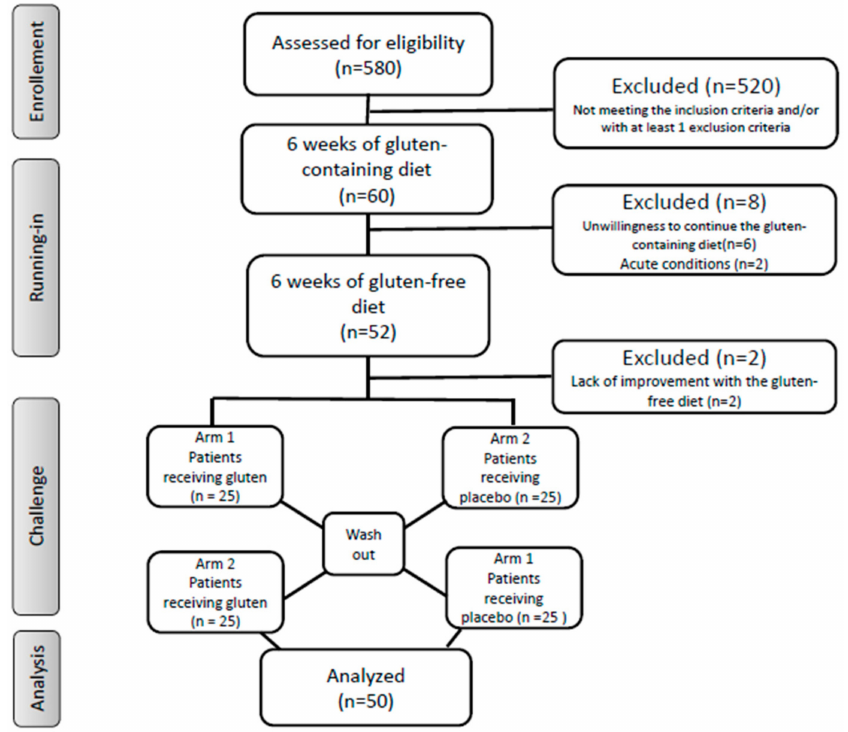
Figure 1. Flow of the